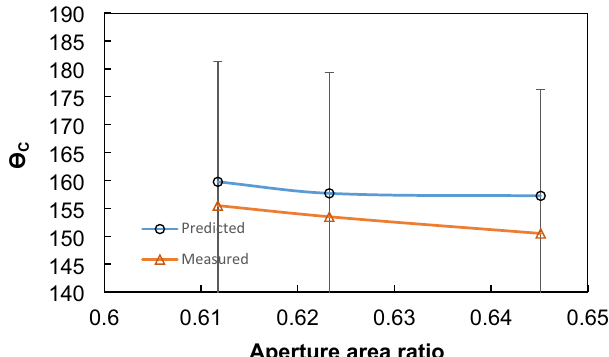
Figure 4. Droplet apparent contact angle predicted and obtained from the experiments with mesh screen open aperture ratio ( A s ).